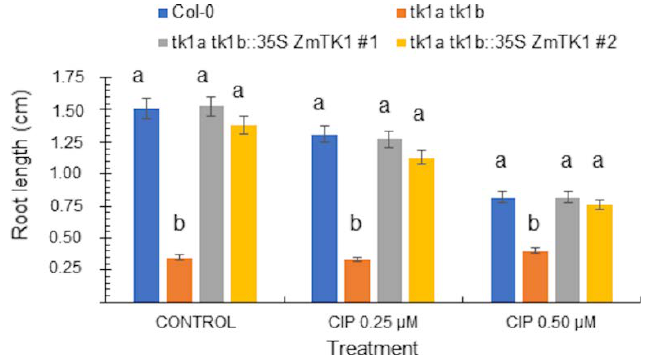
Figure 6. Expression of ZmTK1 in Arabidopsis TK1 double mutant allows the plants to develop in presence of CIP. Col-0, tk1a tk1b double mutant, and double mutants complemented with ZmTK1 were germinated on GB5 agar medium supplemented with CIP and root length was measured in 9-day-old seedlings. Values are averages ± SEs ( n = 20) are shown, and different letters in each treatment indicate significant mean differences, as analyzed by ANOVA followed by Tukey’s comparison test ( p < 0.01).